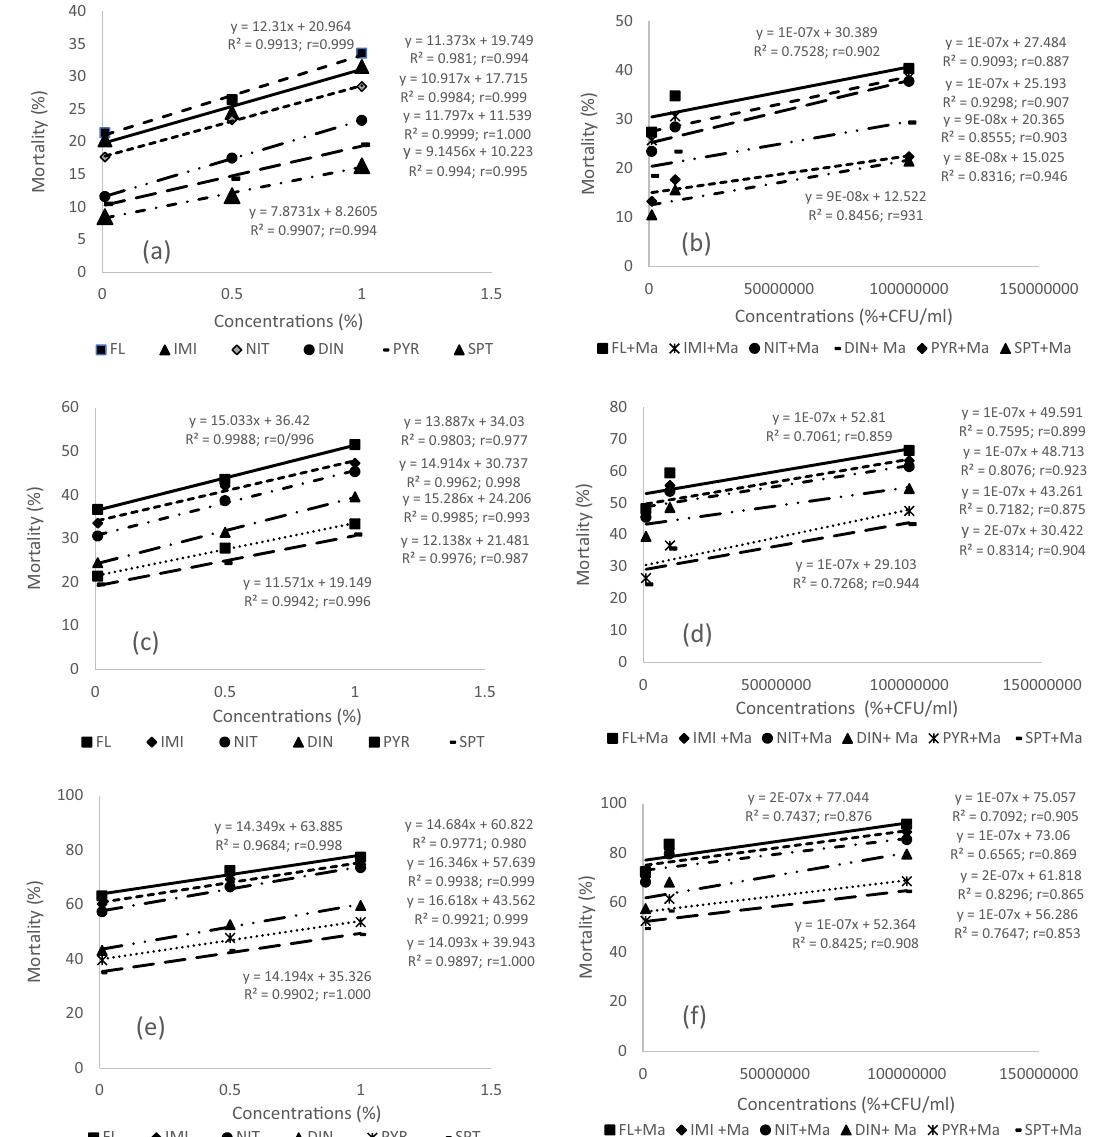
Figure 3. Correlation coefficient (r), linear regression equation (Ŷ = bx ± a), coefficient of determination (100 R 2 ) andscatter plot showing a fitted simple regression lines of Ŷ (% mortality of Aphis gossypii in laboratory conditions) on X (concentration of insecticides alone and in combinations with Metarhizium anisopliae